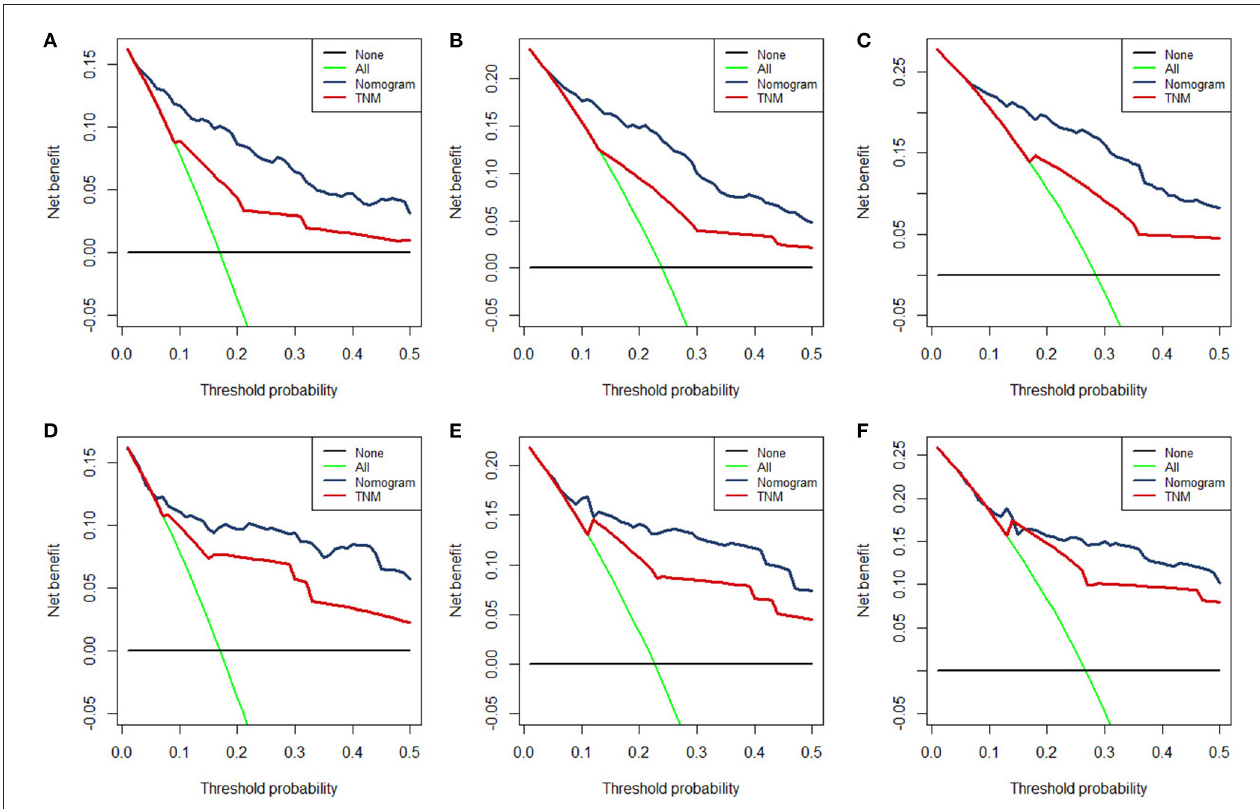
FIGURE 7 | The DCA for 12- (A) , 24- (B) , 36-month (C) , OS prediction in training group and for 12- (D) , 24- (E) , and 36-month (F) OS prediction in the validation group.